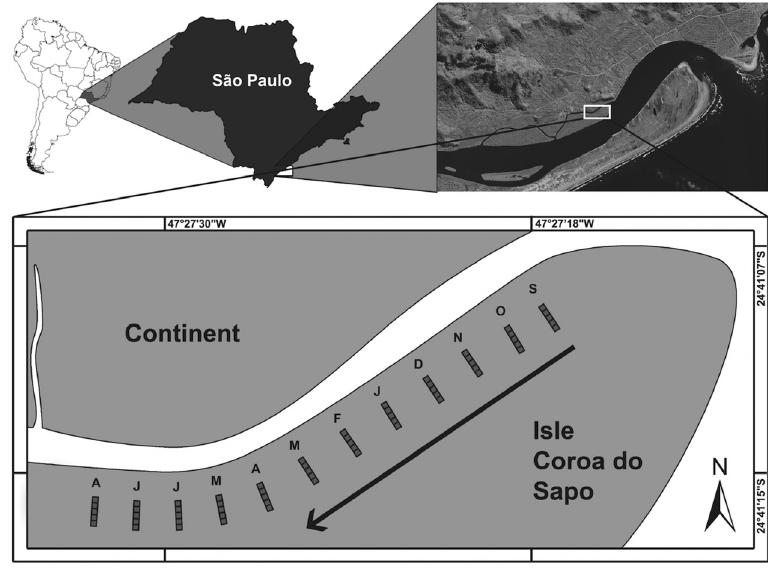
Figure 1 - Location and execution sequence (arrow) of the mangrove areas monthly sampled from September 1998 to August 1999, at ‘Coroa do Sapo’ Island, Municipality of Iguape, São Paulo State, Brazil. Where letters correspond to initial of each month; and art design by Gustavo Pinheiro based on Ikonos IV